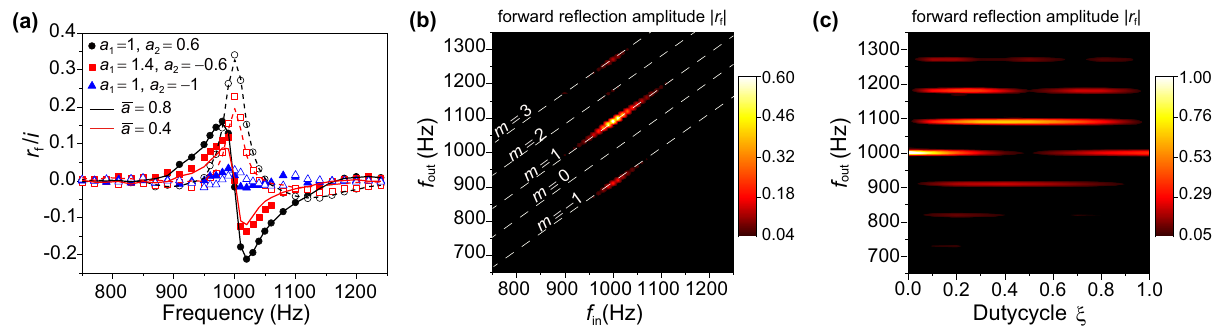
Fig. 2 Ef fi cient frequency conversion for a single time-varying meta-atom with temporally balanced gain and loss. a The experimentally extracted = i ) for a time-varying meta-atom with different modulation amplitudes (symbols) or the static counterpart with effectively forward re fl ection coef fi cient ( r f averaged resonance strength (lines). The fi lled (empty) symbols and solid (dashed) lines denote the real (imaginary) parts. b The 2D map of the forward j (plotted against input and output frequencies f re fl ection amplitude j r and f ) for a time-varying meta-atom, where the dimensionless re fl ection f in out amplitude for each harmonics is normalized to the amplitude of the incident fi eld at input frequency. c The amplitude of forward re fl ection amplitude for ¼ different order harmonics against the modulation duty-cycle ξ at a fi xed input frequency f in